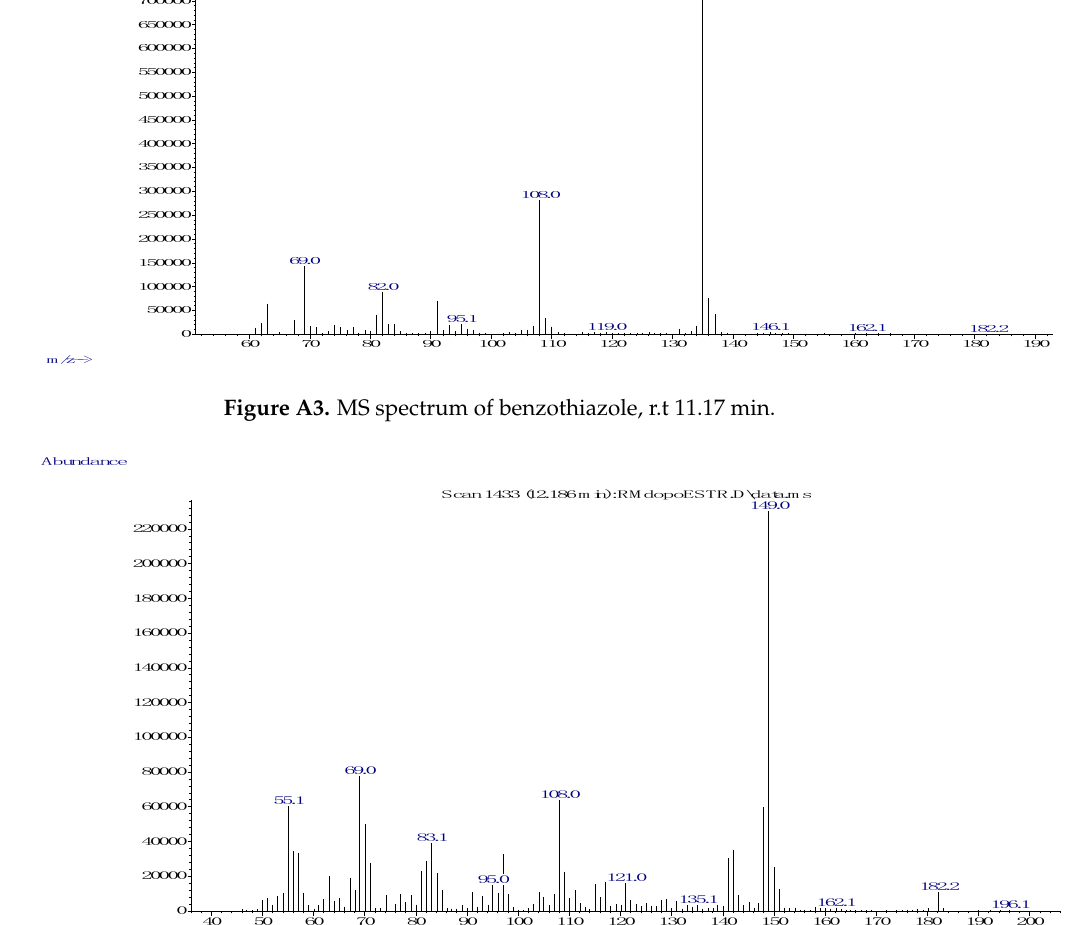
Figure A4. MS spectrum of methylbenzothiazole, r.t 12.19 min.